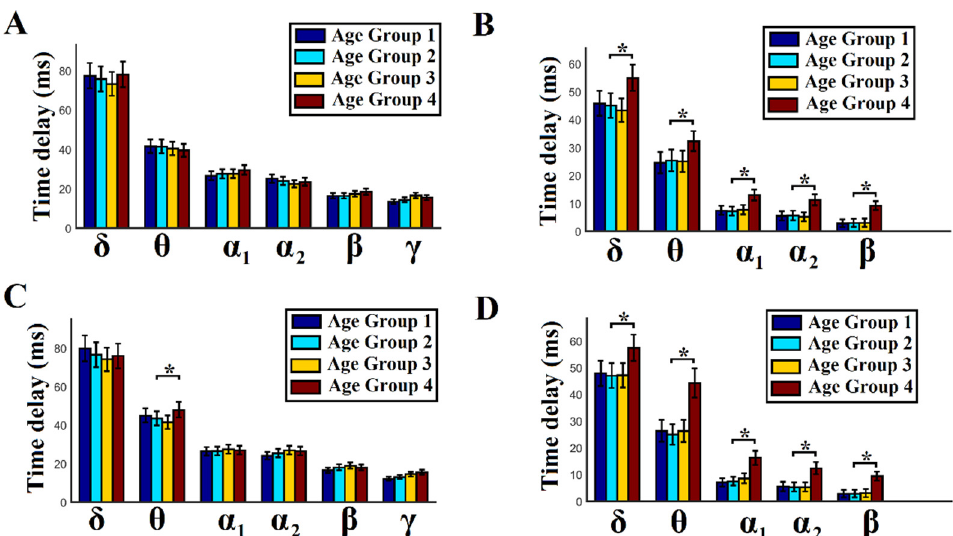
Figure 5. Group-averaged time delays within and between frequencies. ( A ) Group-averaged time delays within frequencies in the amplitude domain. ( B ) Group-averaged time delays between fre- quencies in the amplitude domain. ( C ) Group-averaged time delays within frequencies in the phase domain. ( D ) Group-averaged time delays between frequencies in the phase domain. * denotes that age group 4 is significantly different from all other age groups. (Age group 1: 18–27 years, age group 2: 28–40 years, age group 3: 41–50 years, and age group 4: 51–60 years). For the statistical test, a Wilcoxon rank sum test was adapted (‘*’ p < 0.01, Bonferroni-corrected; p ’< p /6, where 6 refers to the total number of pairwise comparisons across age groups within each frequency band in both BFC and CFC, as well as in both domains separately).